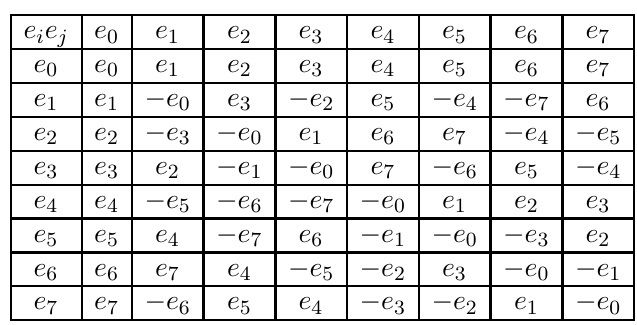
Figure 6 . Cayley-Graves octonion multiplication table. It was recently used in [65] as a starting point for the proposal on quantum computing with